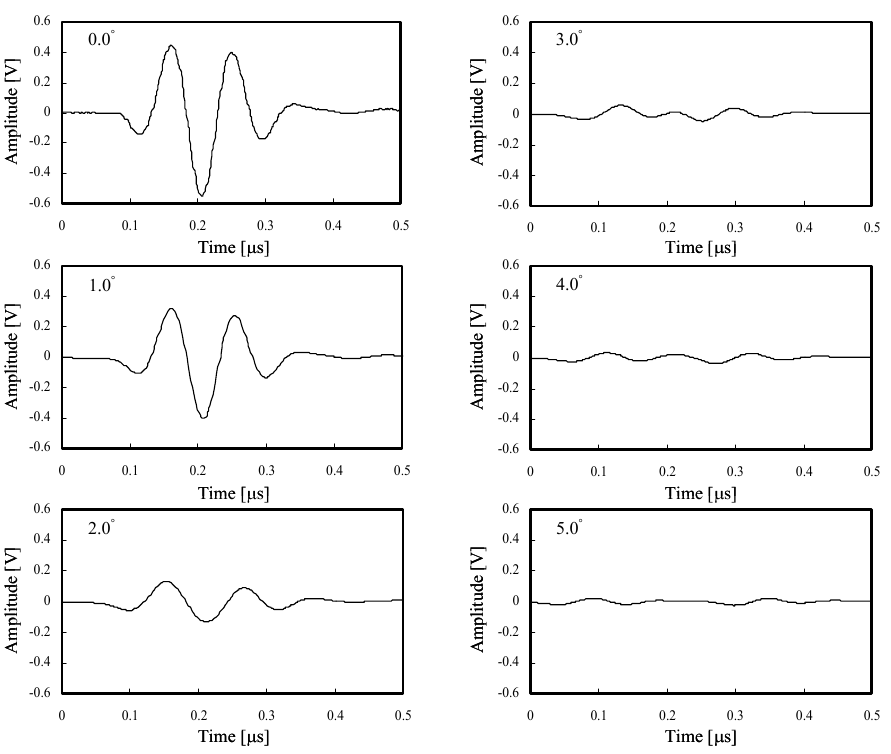
Figure 5: Calculated waveforms using equation (3) under the assumption that the reflection surface is flat plate. articular cartilage surface had lower amplitudes compared with those for the copper and the rubber surfaces, and decreased as the angle of the reflection surface increased as shown in Figure 6. However, the reduction rates show same tendency for all reflection surfaces as shown in Figure 7. Also, roughing an 80% decrease was observed for a reflection surface angle of 5.0 degrees. The “Rise-to-Peak From these results,